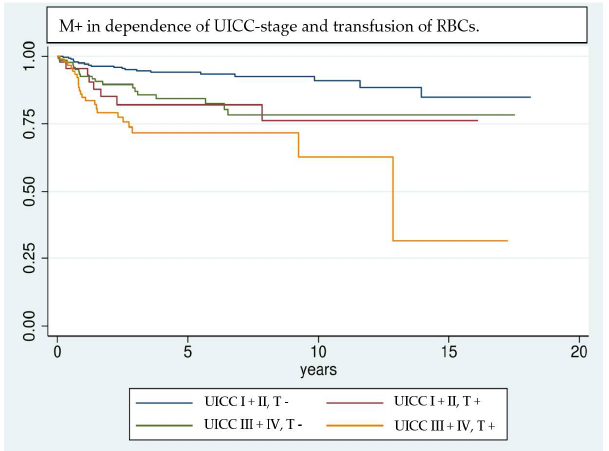
Figure 4. Comparison of patients according to their transfusion status (T +/-) and UICC classification UICC I + II vs. UICC III + IV) using Kaplan–Meier analysis. Patients with advanced tumor disease (UICC III + IV) but without RBC transfusion show a comparable trend in developing M+ as patients who are diagnosed in an earlier stage of disease (UICC I + II) but received transfusions in the perioperative management.